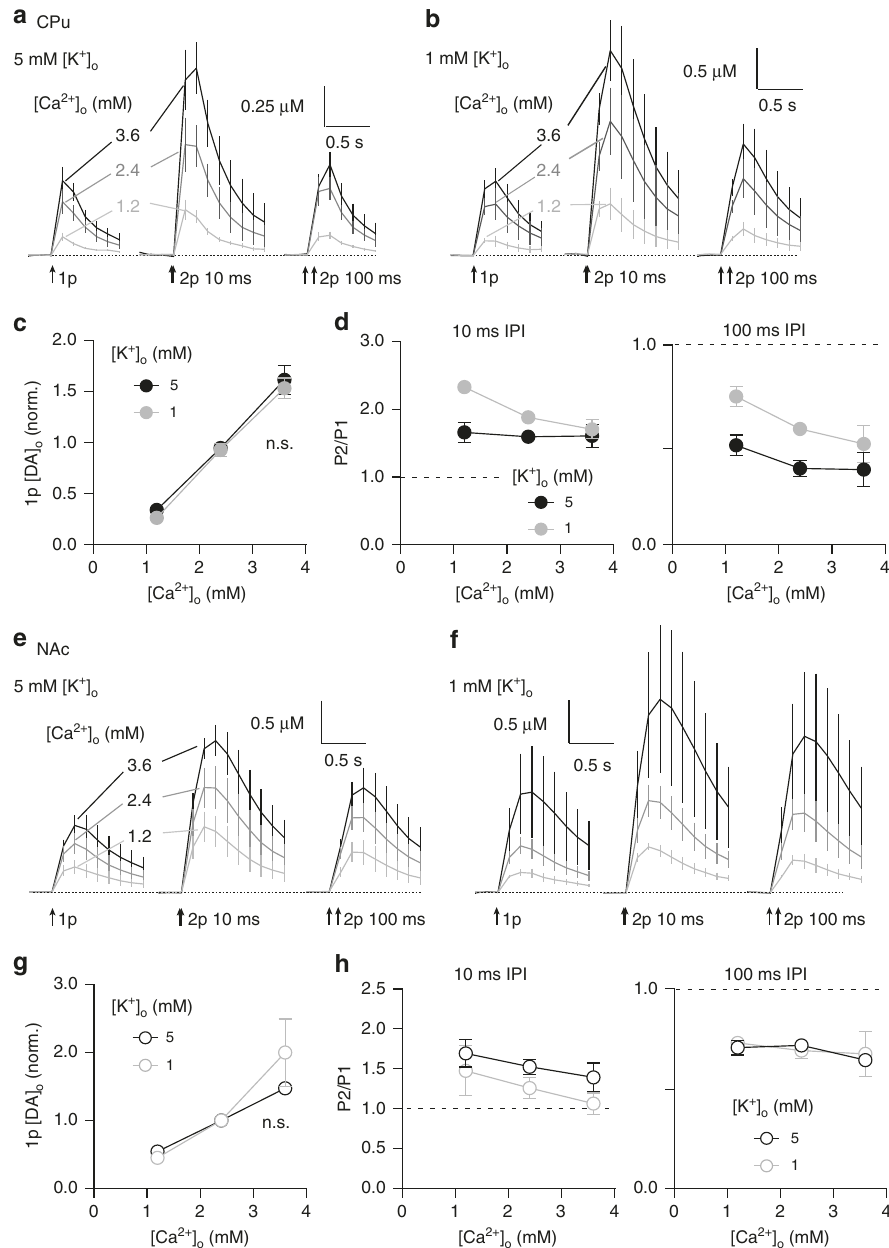
Fig. 5 K + -dependent gating does not alter release-dependence of short-term plasticity. a , b , e , f Mean pro fi les of [DA] o transients elicited by single or paired pulses in 1.2 mM [Ca 2 + ] (light grey), 2.4 mM [Ca 2 + ] o (dark grey) and 3.6 mM [Ca 2 + ] o (black) in either 5 mM [K + ] o ( a , e ) or 1 mM [K + ] o ( b , f ) in CPu ( a , b , n = 11) and in NAc ( e , f , n = 7). c , g Mean peak 1p [DA] o (± SEM, normalised to 2.4 mM [Ca 2 + ] o ) in 5 mM [K + ] o (black) and 1 mM [K + ] o (grey) in CPu ( c ) and in NAc ( g ). d , h Mean P2/P1 at 10 ms IPI (left) and 100 ms IPI (right) in 5 mM [K + ] o (black) and 1 mM [K + ] o (grey) in CPu ( d ) and in NAc ( h ). Two-way ANOVA with Bonferroni ’ s test for post hoc comparisons. Error bars are ± SEM. Source data are provided as a Source Data fi